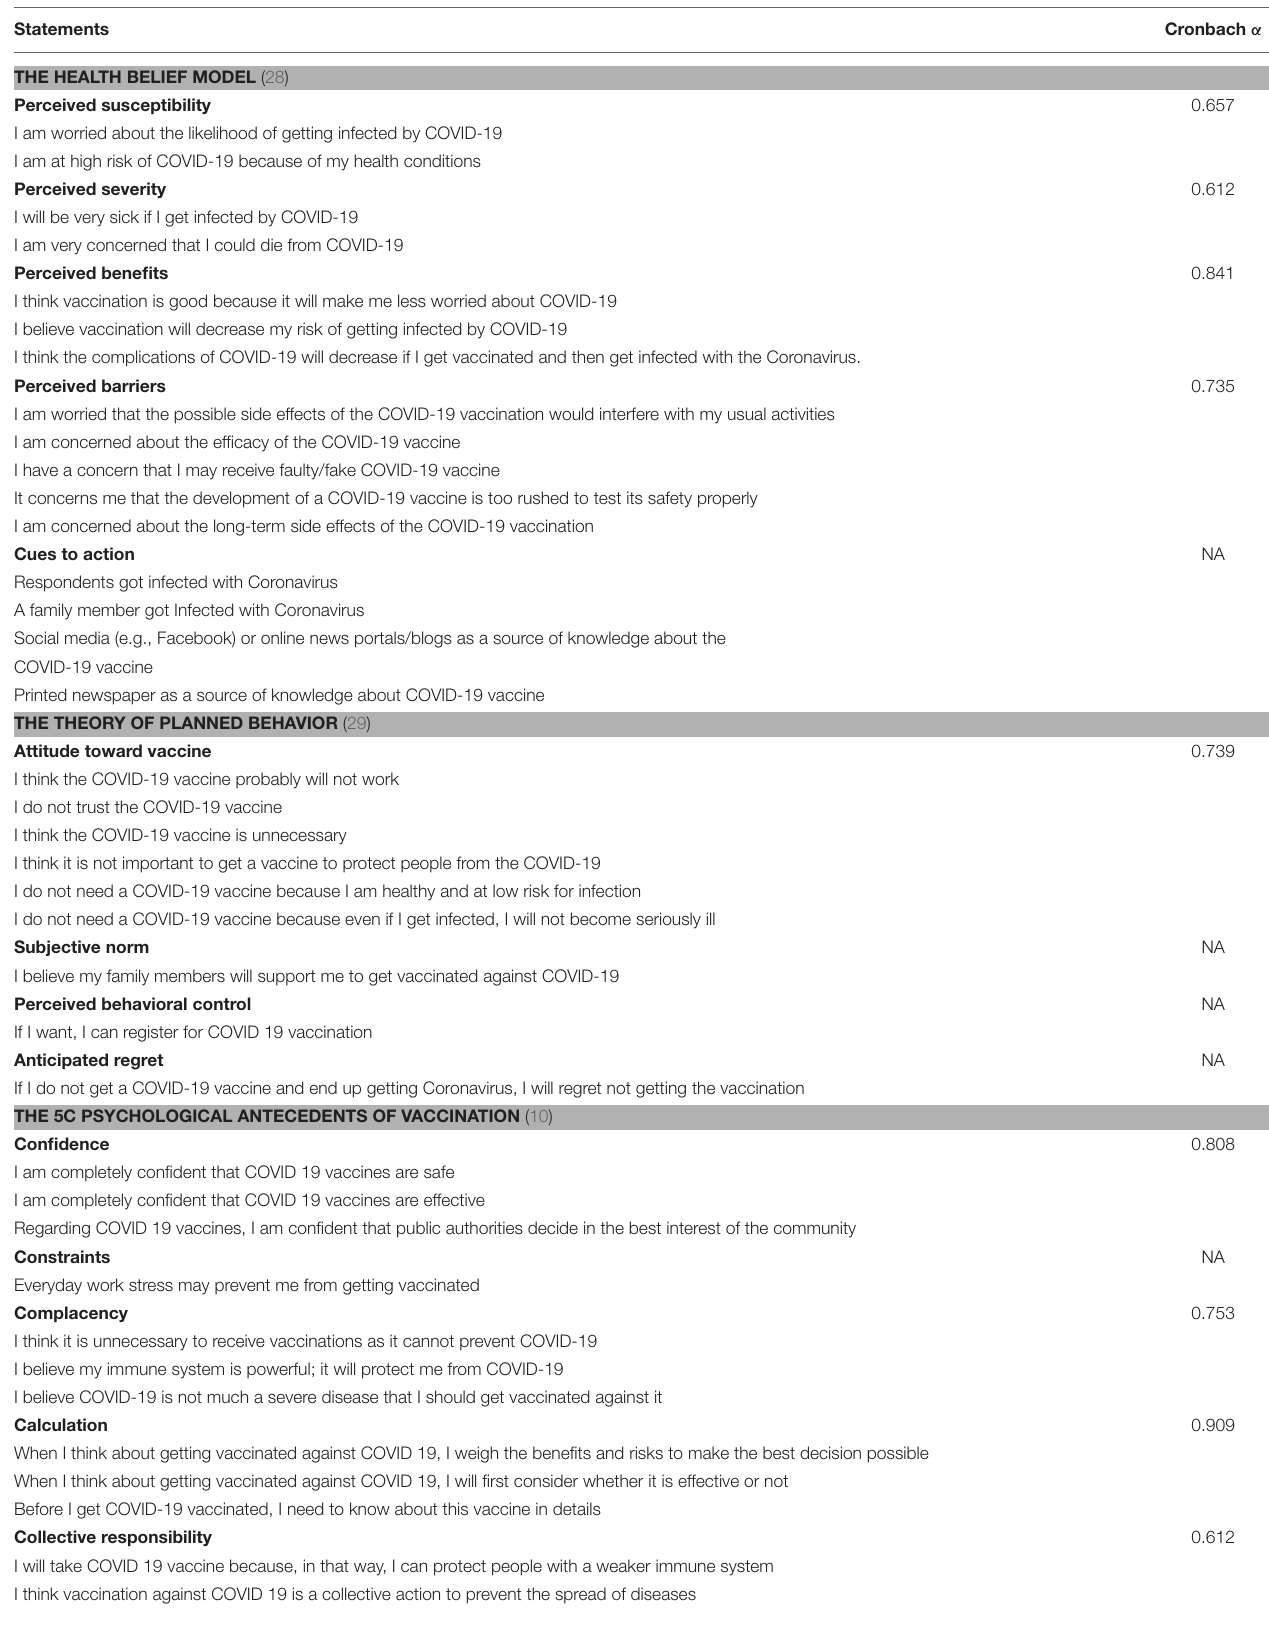
TABLE 1 | Items used to measure HBM, TPB, and 5C psychological